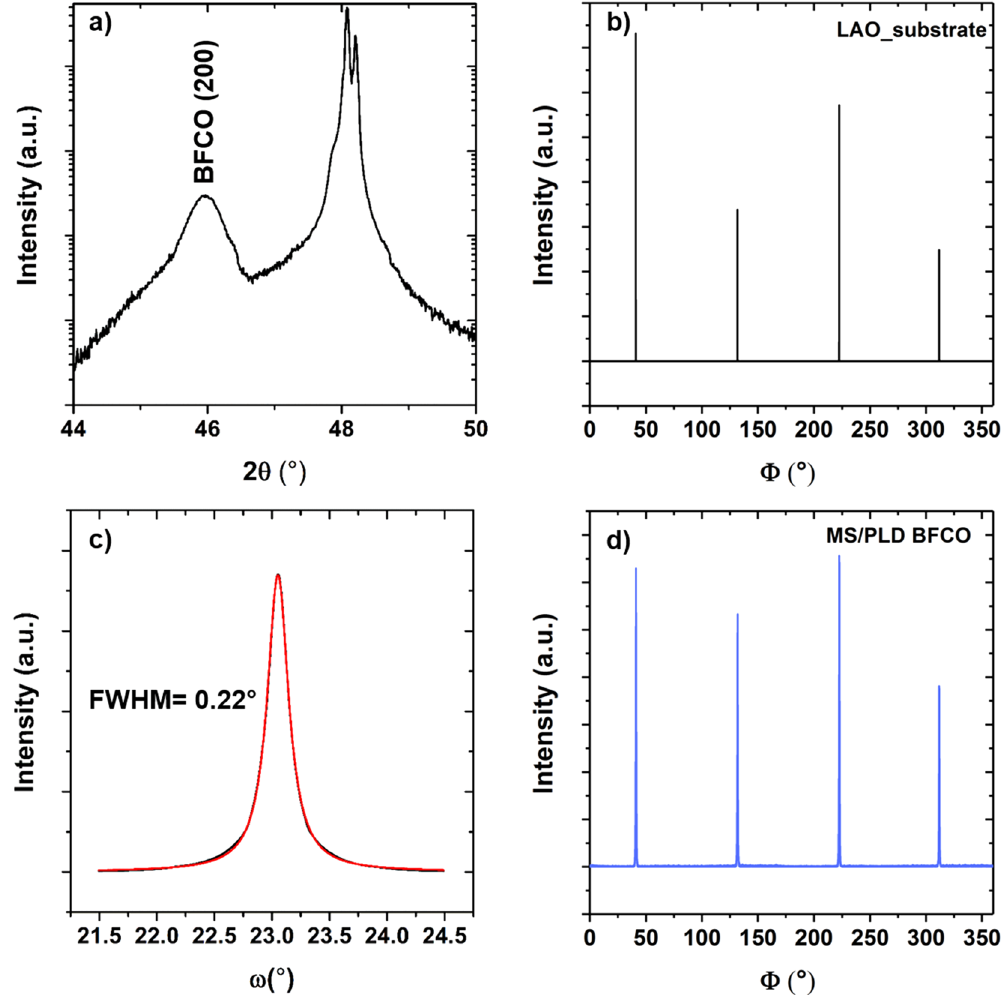
Figure 6. Detailed diffraction data from the BFCO layer grown at 750 °C with the hybrid technique. (a) 2 θ -scan and (c) rocking curve of BFCO(002) peak. The red line is a Lorentzian fit to the data (black). Corresponding ϕ -scan measurements around the (200) reflection on the bare substrate (b) and the BFCO film (d) confirm the epitaxial growth of the